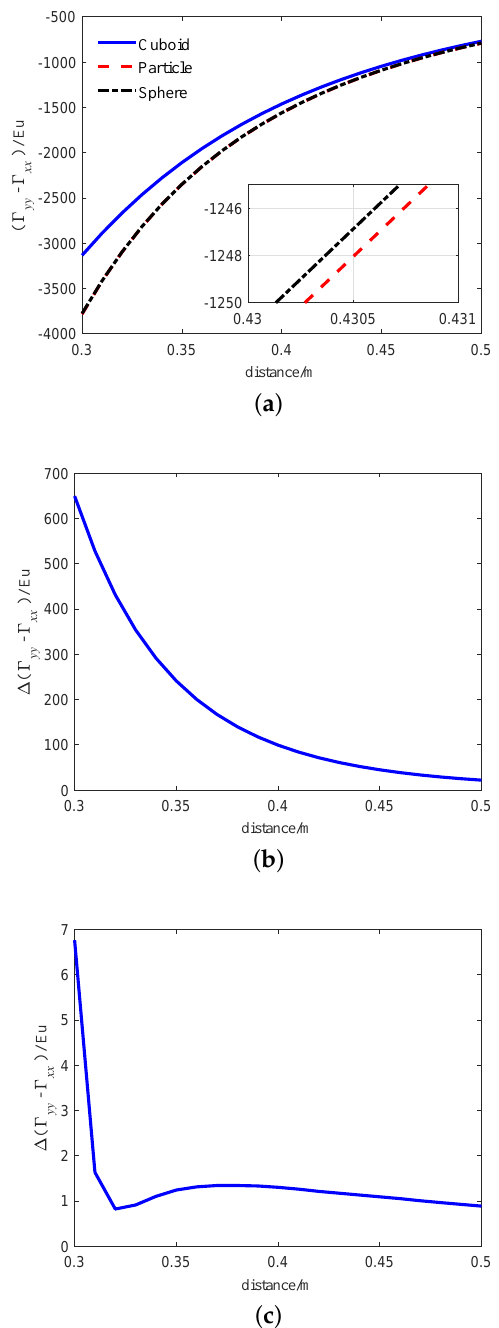
Figure 9. Real-gravity gradient for the RAGG caused by the particle and the cuboid which are the same mass. ( a ) The relationship between the real-gravity gradient for the RAGG caused by the particle and the cuboid and the distance. ( b ) The relationship between the Real-gravity gradient error for the RAGG caused by the particle and the cuboid and the distance. ( c ) The relationship between the Real-gravity gradient error for the RAGG caused by the particle and the sphere and the